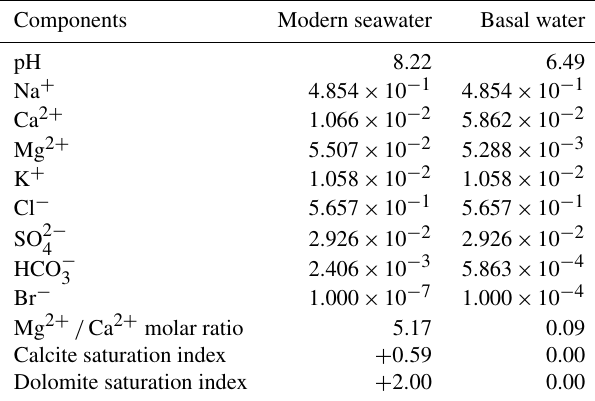
Table 2. Chemical composition of end-member fluids in reactive transport analysis. Primary aqueous species concentrations are in moles per kilogram (molkg − 1 ) of H 2 O; mineral saturation indices are log ( IAP / K ) . Br − is used as a non-reactive tracer of the contri- bution of basal